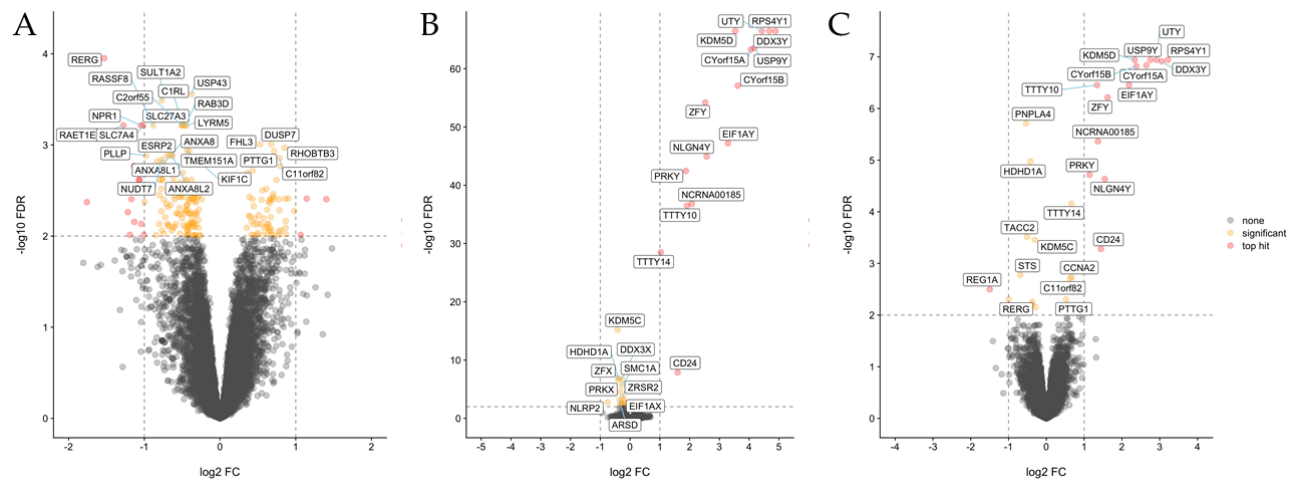
Figure 4. Differential expression analysis of 129 MPM tumors. Volcano plots representing differentially expressed genes between ( A ) tumors expressing high RERG vs. tumors exhibiting low RERG in women; ( B ) women and men; ( C ) tumors of women expressing high RERG vs. all the other samples. The − log10 false discovery rate (FDR) was plotted against log2 fold change (FC) values for all tested genes. The symbols on the negative and positive values of x -axis in each figure represent downregulated and upregulated genes, respectively. Symbols corresponding to significantly differentially expressed genes (FDR < 0.05) and top hit genes (FDR < 0.05 and 2-fold change) are colored in yellow and red,